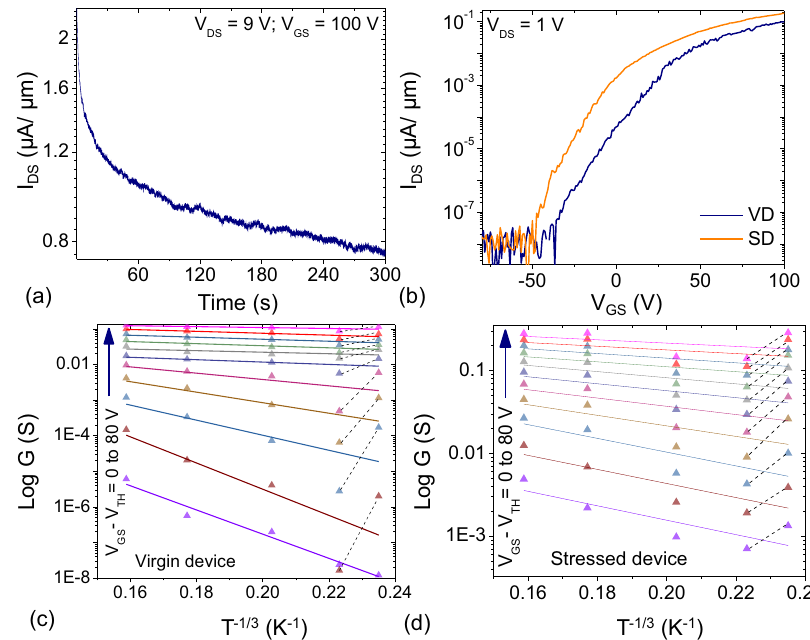
Fig. 3 Long-term electrical stress (LTES)-induced variations in the electrical properties of MoS 2 . a Current versus time characteristics during a prolonged operation in the high fi eld regime and ON state. Monotonic decay in current is attributed to self-heating and eventual establishment of thermal equilibrium between electrons and lattice which shows up as the onset of saturation after 50 s. b Negative shift in the threshold voltage and an increase in the overall conductance are found to be two major fallouts of LTES. Temperature dependence of conductance in c virgin (VD) and d stressed device (SD) at different gate overdrive voltage values. The temperature-dependent data from VD and SD are fi tted to Mott VRH model, in Eq. (1), and are denoted by straight lines. Stress-induced defects seem to have weakened hopping transport in SD while improving the overall device conductance and resulting in enhanced screening at the same carrier concentration. Note: dotted lines represent the onset of metal-insulator transition, more prominent in SDs than that in